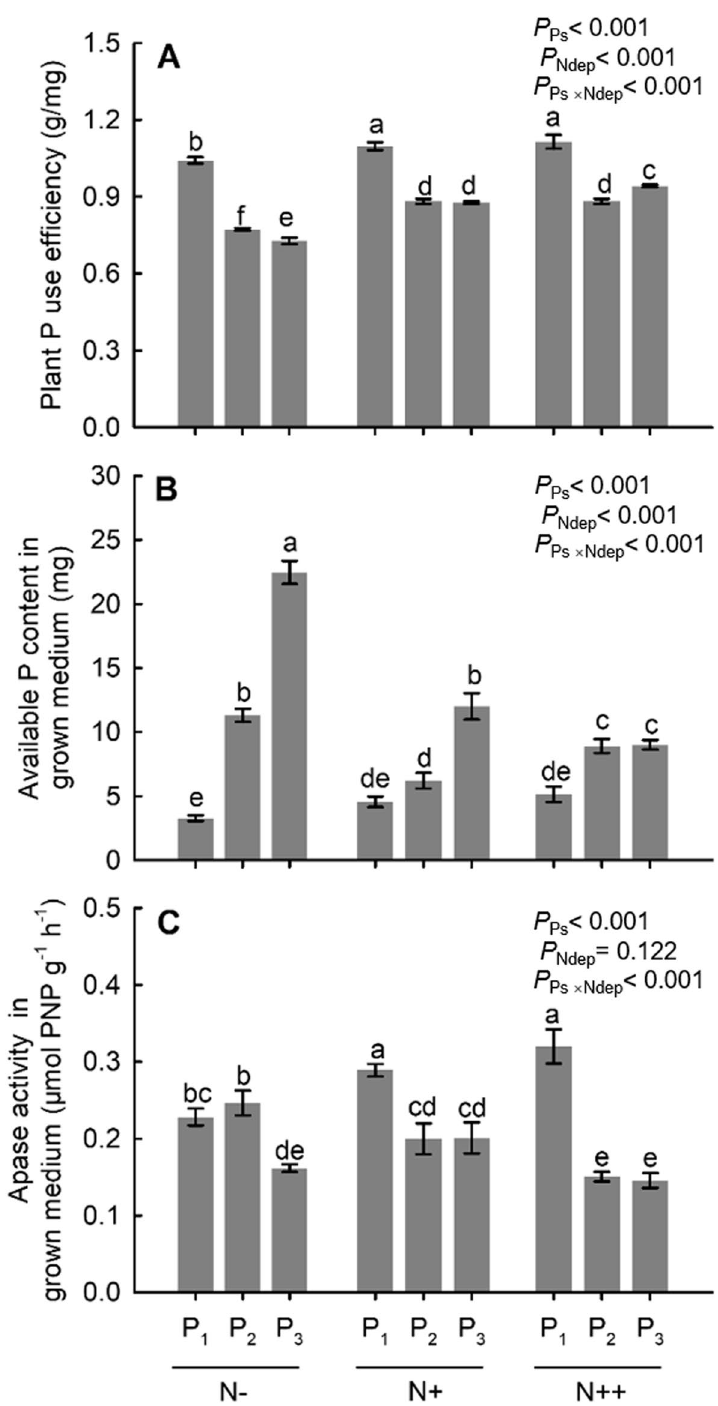
Fig. 5 Plant P use efficiency (PUE) ( A ), available P content ( B ), and acid phosphatase (Apase) activity ( C ) of rhizosphere soil in response to experimental N deposition rate under different soil P availability. Different lowercase letters indicate significant differences among different treatments (Tukey’s HSD, α 0.05). Vertical bars represent standard error from the mean at each sampling ( n =